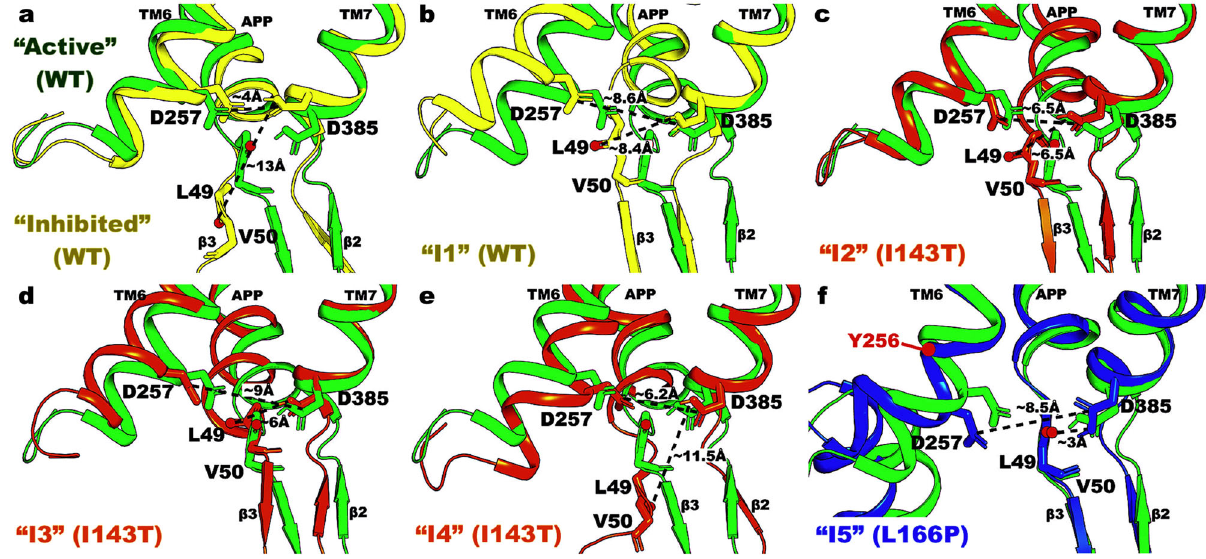
Fig. 3 Distinct low-energy conformational states of catalytic aspartates and enzyme-substrate interactions at the active site of WT and PS1 FAD mutant γ -secretase compared to “ Active ” WT conformation. a The “ Inhibited ” state, for which the distance between PS1 residues D257 and D385 is ~4.1 Å, and the distance between PS1 residue D385 and APP residue L49 is ~12.5 Å. b The “ I1 ” state, for which the distance between PS1 residues D257 and D385 is ~8.6 Å, and the distance between PS1 residue D385 and APP residue L49 is ~8.4 Å. c The “ I2 ” state, for which the distance between PS1 residues D257 and D385 is ~6.5 Å, and the distance between PS1 residue D385 and APP residue L49 is ~6.5 Å. d The “ I3 ” state, for which the distance between PS1 residues D257 and D385 is ~8.8 Å, and the distance between PS1 residue D385 and APP residue L49 is ~6.1 Å. e The “ I4 ” state, for which the distance between PS1 residues D257 and D385 is ~6.2 Å, and the distance between PS1 residue D385 and APP residue L49 is ~11.5 Å. f The “ I5 ” state, for which the distance between PS1 residues D257 and D385 is ~8.5 Å, and the distance between PS1 residue D385 and APP residue L49 is ~2.9 Å. The “ Active ” WT low- energy conformation is shown in green for